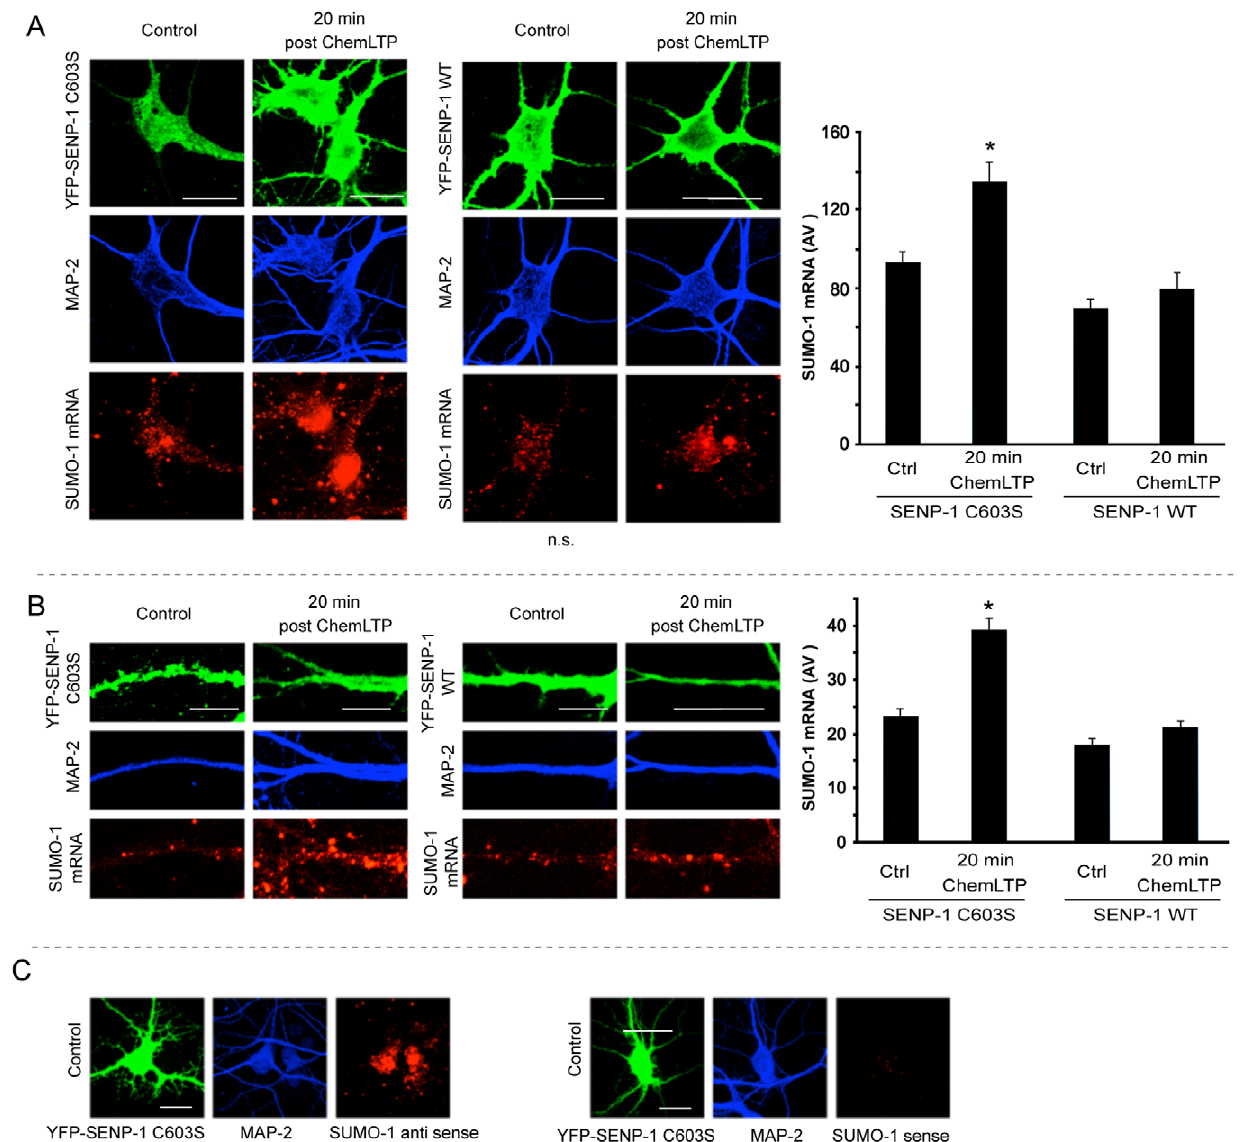
Figure 5. Overexpression of SENP-1 diminishes the ChemLTP-mediated increase in SUMO-1 mRNA. A) Representative images showing effects of ChemLTP in the soma and processes of hippocampal neurons overexpressing SENP-1 C603S (inactive control) or SENP-1 WT (green). Fluorescence in situ hybridization was performed using cRNA probes for SUMO-1 (red). Neurons were then co-stained with MAP-2 (blue). Graph shows quantification of mean fluorescence intensity (arbitrary units) in soma quantified from 4 independent experiments with 8–12 neurons per condition using ImageJ. B) Representative examples of dendritic regions of neurons overexpressing SENP-1 C603S (inactive control) or WT. Graph shows quantification of mean fluorescence intensity (arbitrary units) in dendrites. Quantification from 4 independent experiments; each experiment: 8–12 neurons per condition and 4 dendrites per neuron, done using ImageJ Scale bars – 5 m m. C) In situ hybridization with SUMO-1 negative control (sense probe) yielded virtually no signal compared to the anti-sense (experimental) probe. Scale bars – 20 m m. In all cases statistical significance was determined using ANOVA followed by Bonferroni post-hoc test (*p , 0.01).